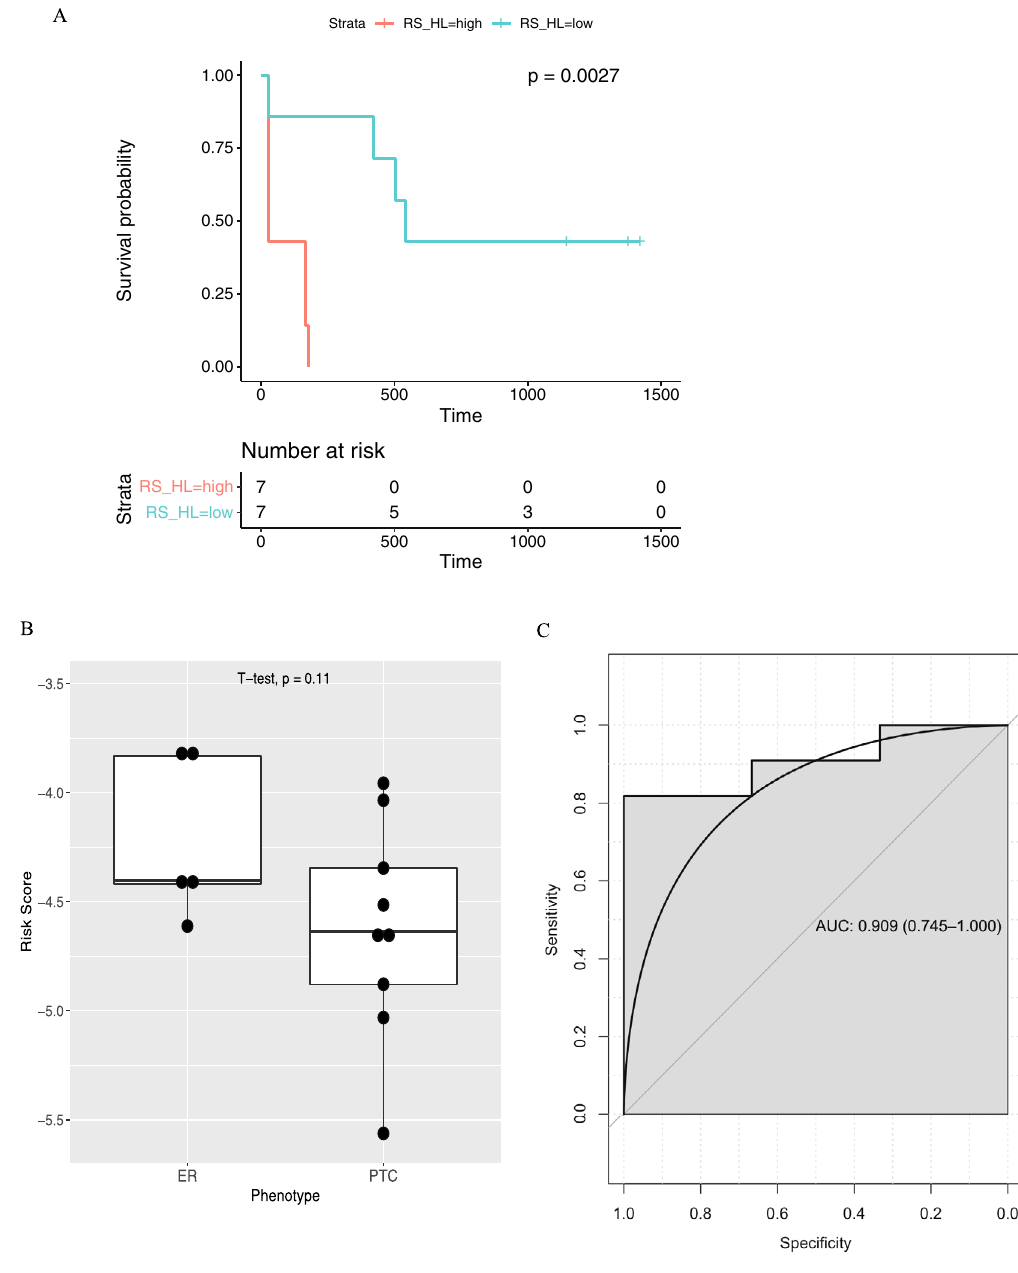
Figure 3. Survival analysis and gene signature validation. ( A ) Kaplan–Meier survival analysis of gene expression-based Risk Score (RS) comprising genes ISG15, XAF1, USP18 and TRIM25 , predicting the likelihood of early and late post-TI rebound. Blue and red lines represent low and high-risk score, respectively, divided by the mean cohort score. ‘+’ represents censored samples. ( B ) Expression of the risk score genes for each participant plotted for different phenotypes. ER early rebounder, PTC post-treatment controller. ( C ) ROC curve demonstrating efficiency of applying the Risk Score to identify participants that reported rebound versus those that did not. AUC area under the curve; confidence interval in